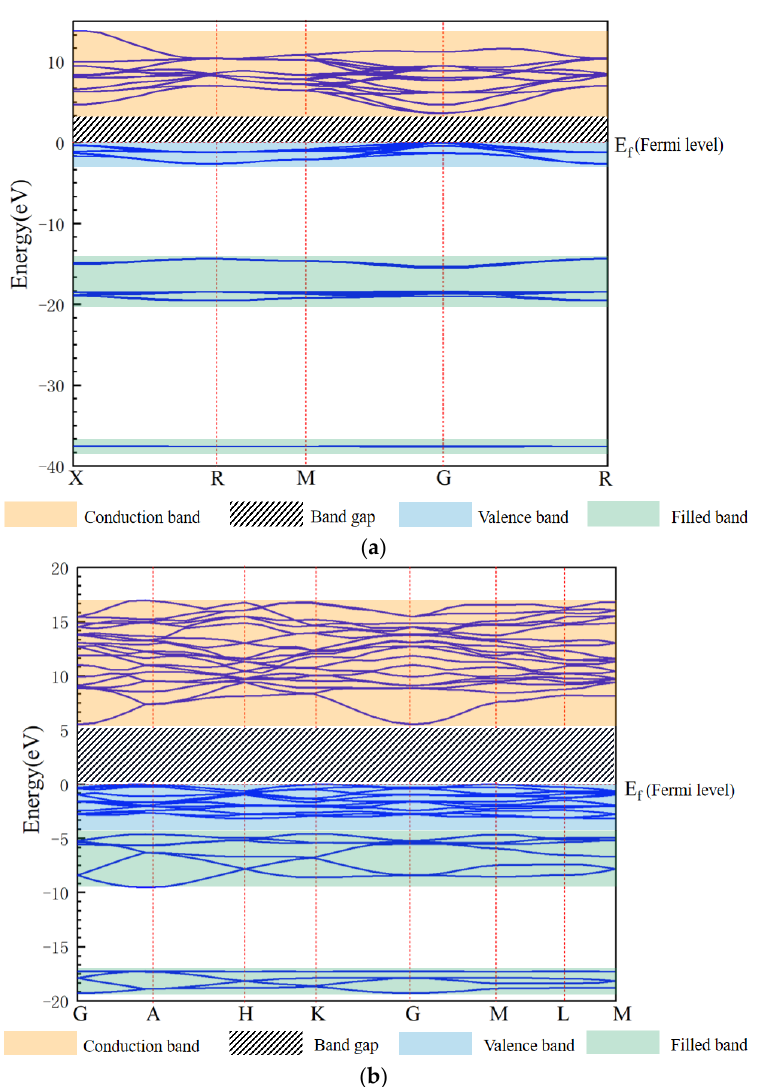
Figure 10. Energy band structure diagram of calcium oxide and silica: ( a ) band structure diagram of CaO; ( b ) band structure diagram of SiO 2 .